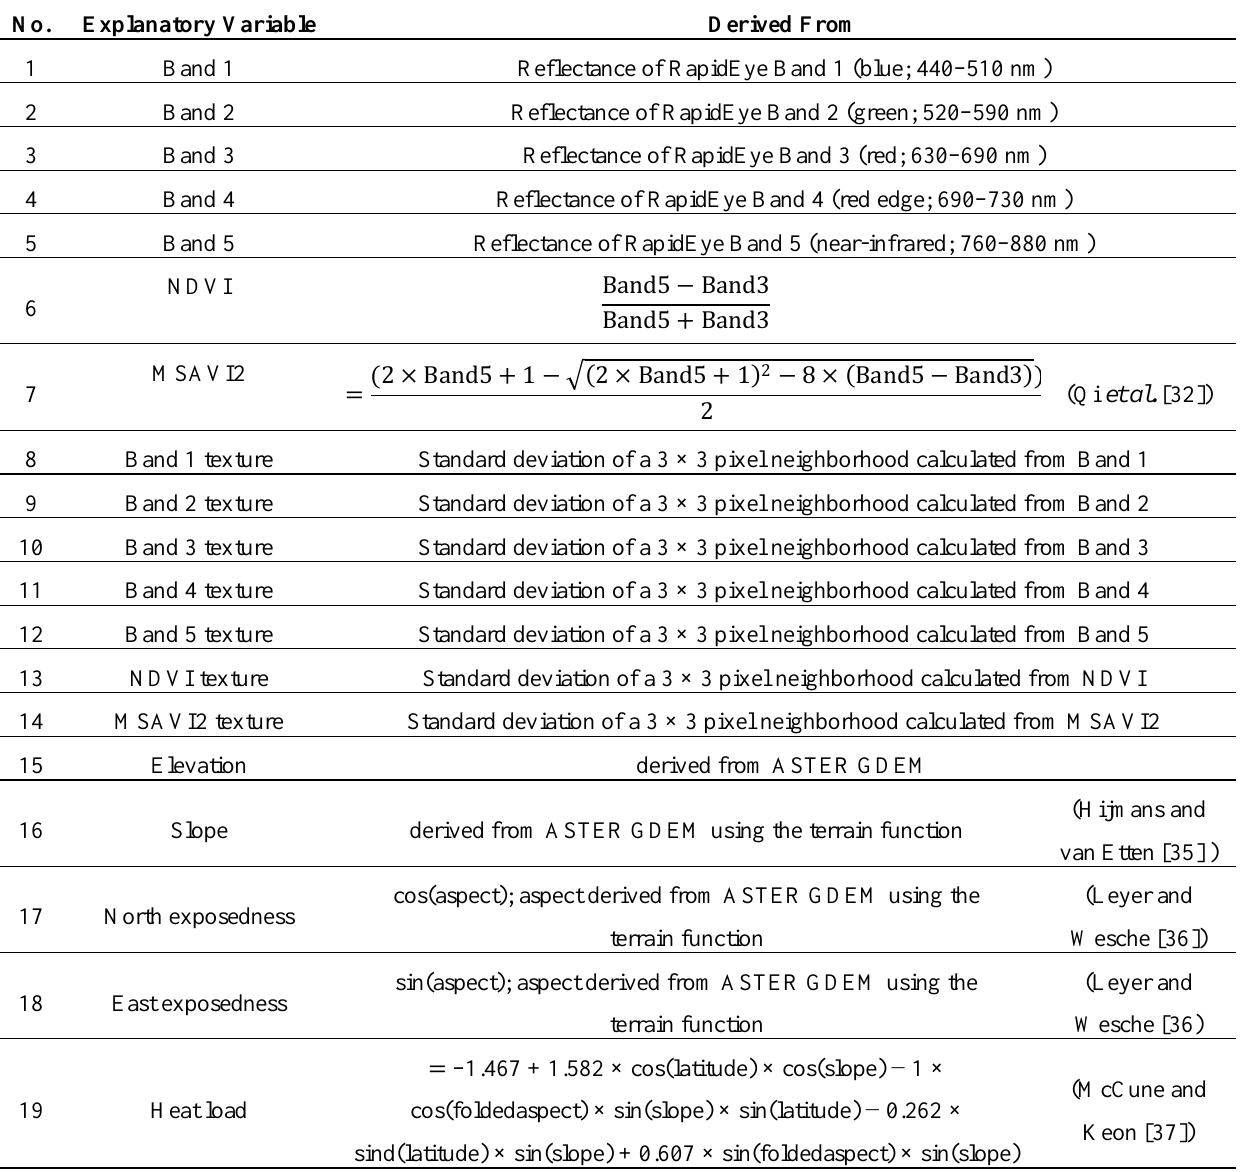
Table 1. Description of the utilized explanatory variables (NIR = near-infrared, RE = red edge, R =